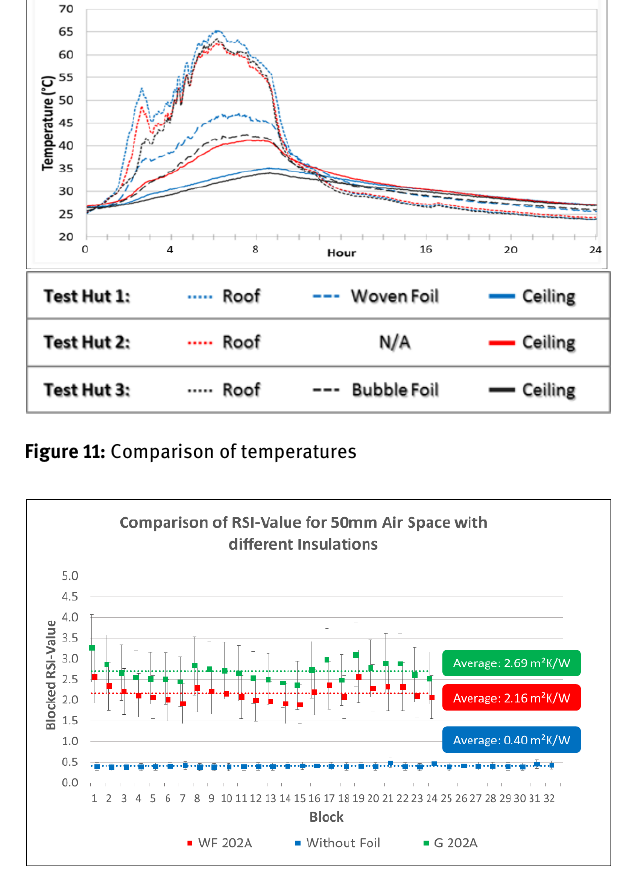
Figure 12: RSI-values for three test huts for a 24-hour period